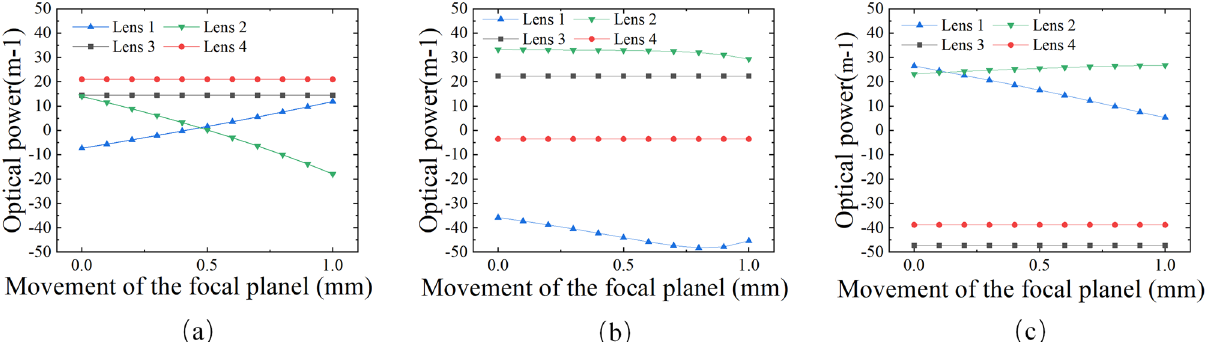
Figure 6. Corresponding relationship between optical power of the proposed varifocal lens and the movement (z) of the focal plane at different magnifications (M). ( a ) 10×. ( b ) 20×. ( c )